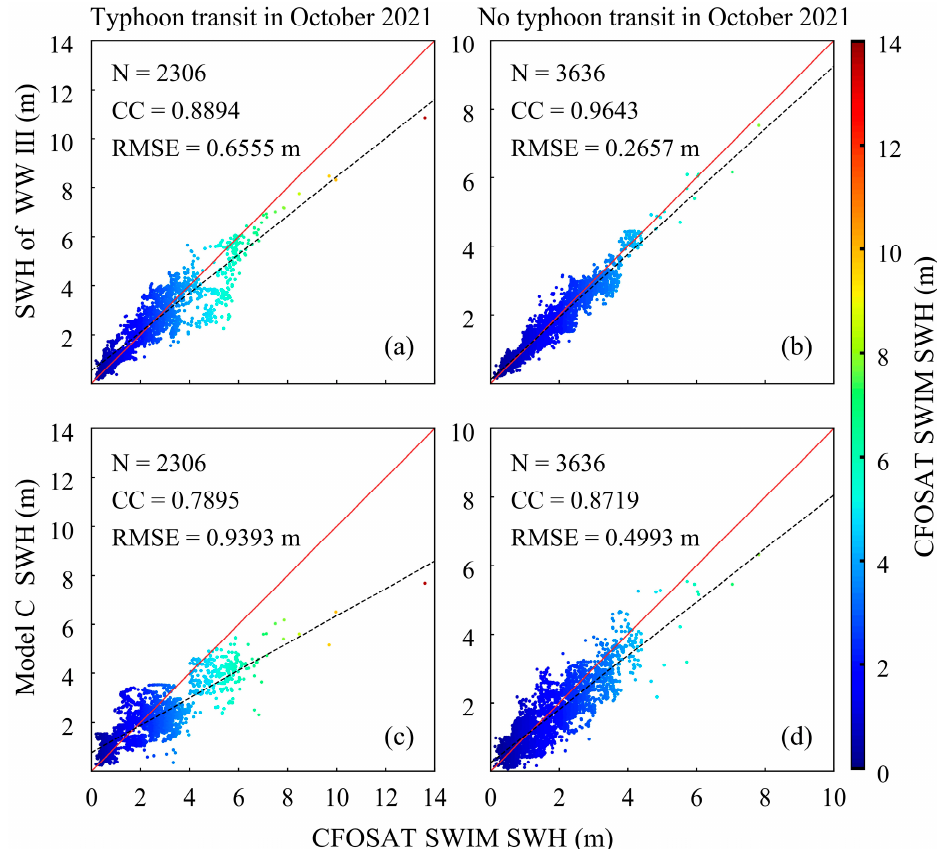
Figure 11. SWH accuracy of WWIII and Model C in comparison to CFOSAT SWIM SWH. ( a ) Cor- relation between SWH of WWIII and CFOSAT SWIM SWH during typhoon transit; ( b ) Correla- tion between SWH of WWIII and CFOSAT SWIM SWH during no typhoon transit; ( c ) Correlation between Model C SWH and CFOSAT SWIM SWH during typhoon transit; ( d ) Correlation be- tween Model C SWH and CFOSAT SWIM SWH during no typhoon transit. tion between Model C SWH and CFOSAT SWIM SWH during no typhoon